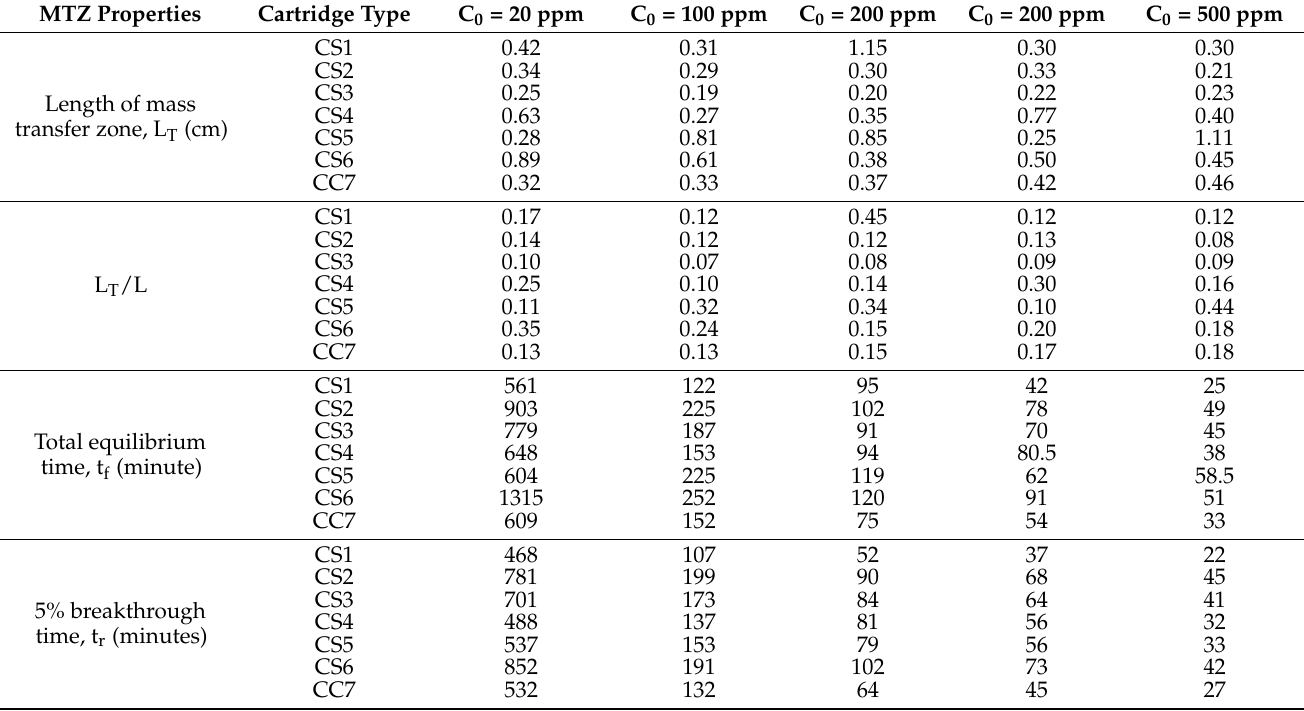
Table 4. Mass transfer zone (MTZ) properties from breakthrough curves by cartridge type and toluene concentration (bed length (L) = 2.54 cm, flow rate = 32